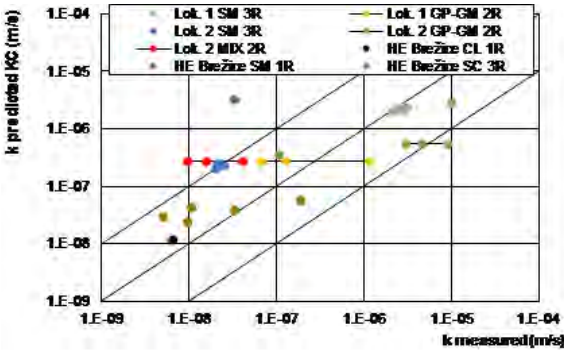
Figure 24. Comparison of calculated (KC) and mea- sured hydraulic conductivity